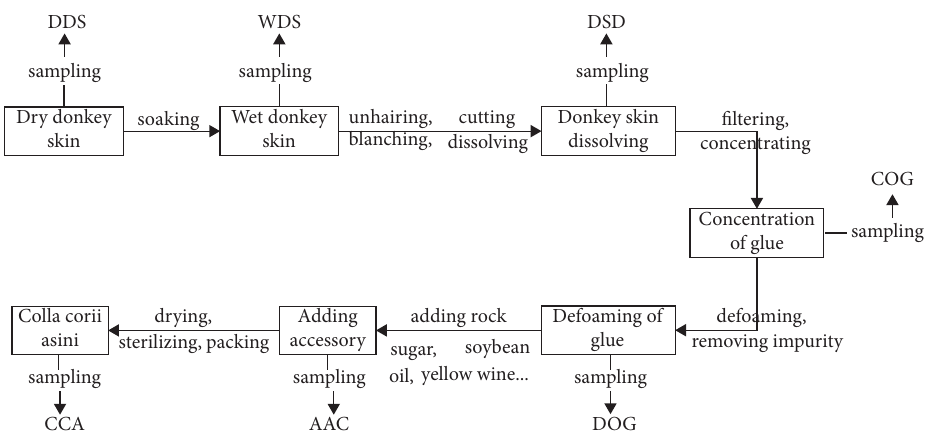
Figure 1: Specifc information of the sampling point and the processing